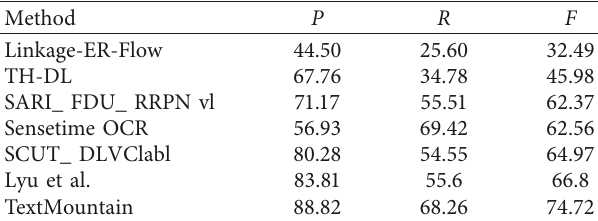
Table 7: Comparison between TextMountain and other methods.